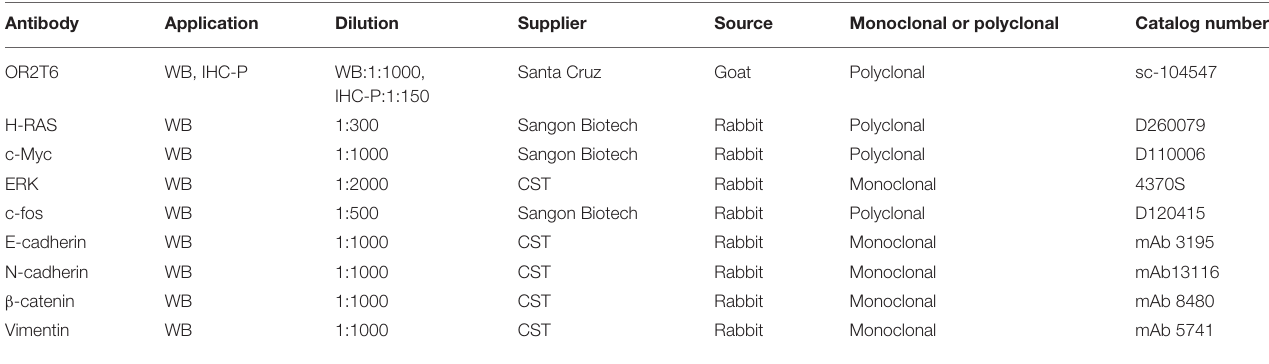
TABLE 1 | Primary antibodies used in this